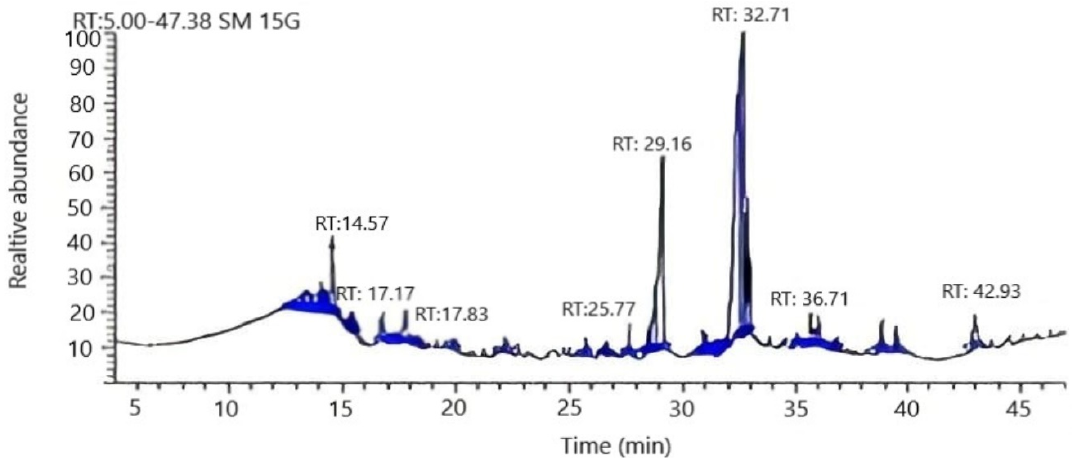
Figure 2. Gas chromatograms of intracellular fatty acid composition of the endophytic Arthrographis kalrae isolate. Table 1. Gas chromatography–mass spectrometry (GC-MS) analysis of Arthrographis kalrae fatty acids.